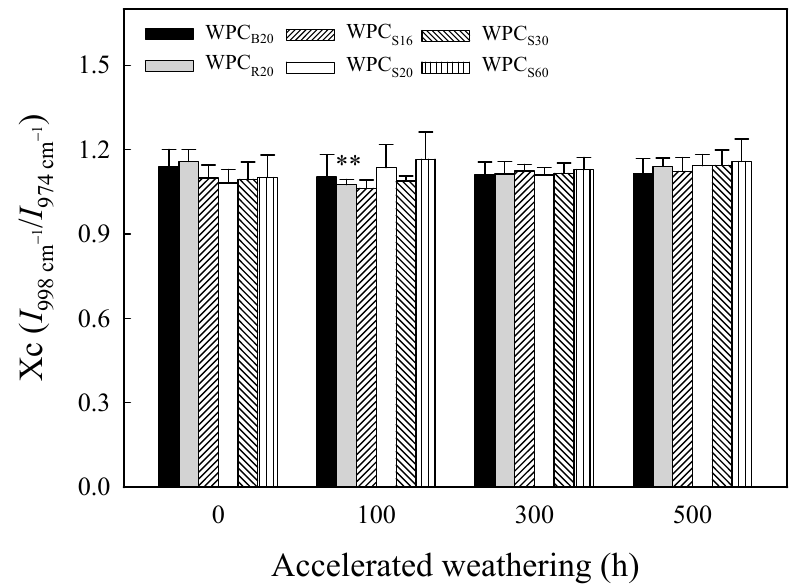
Figure 6. The Xc values of various WPCs before and after xenon arc accelerated weathering for 100, 300, and 500 h. Values are the mean ± SD ( n = 5). **: p < 0.01 (one-tailed test) compared to the unweathered WPC.